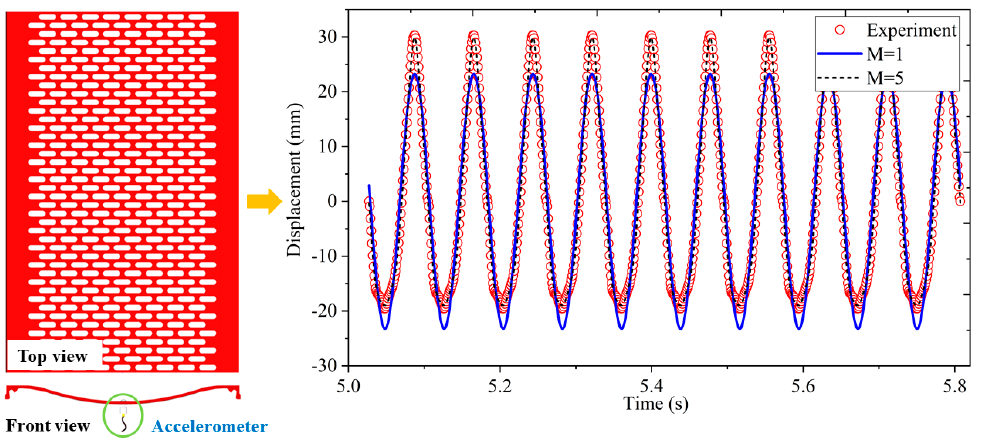
Figure 3. Fourier series analysis of amplitude at the midpoint of the sieve mat. The displacement signal of the measuring point on the screen surface is not a regular simple harmonic function but periodic. Fortunately, any periodic function of time can be represented by the Fourier series as an infinite sum of sine and cosine terms [22]. Its Fourier series representation is given by Equation